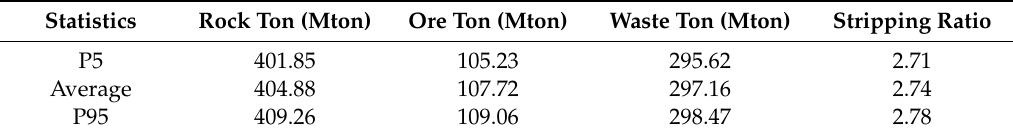
Figure 7. Ultimate pit limit probability. Table 2. Summary statistics (average, 5th and 95th percentiles over 100 realizations of grades, specific gravity and magnetic ratio) of the ultimate pit included in the 95% pit limit